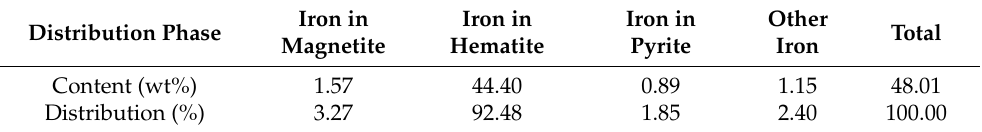
Table 3. Results of sulfur phase analysis on cyanide tailings.